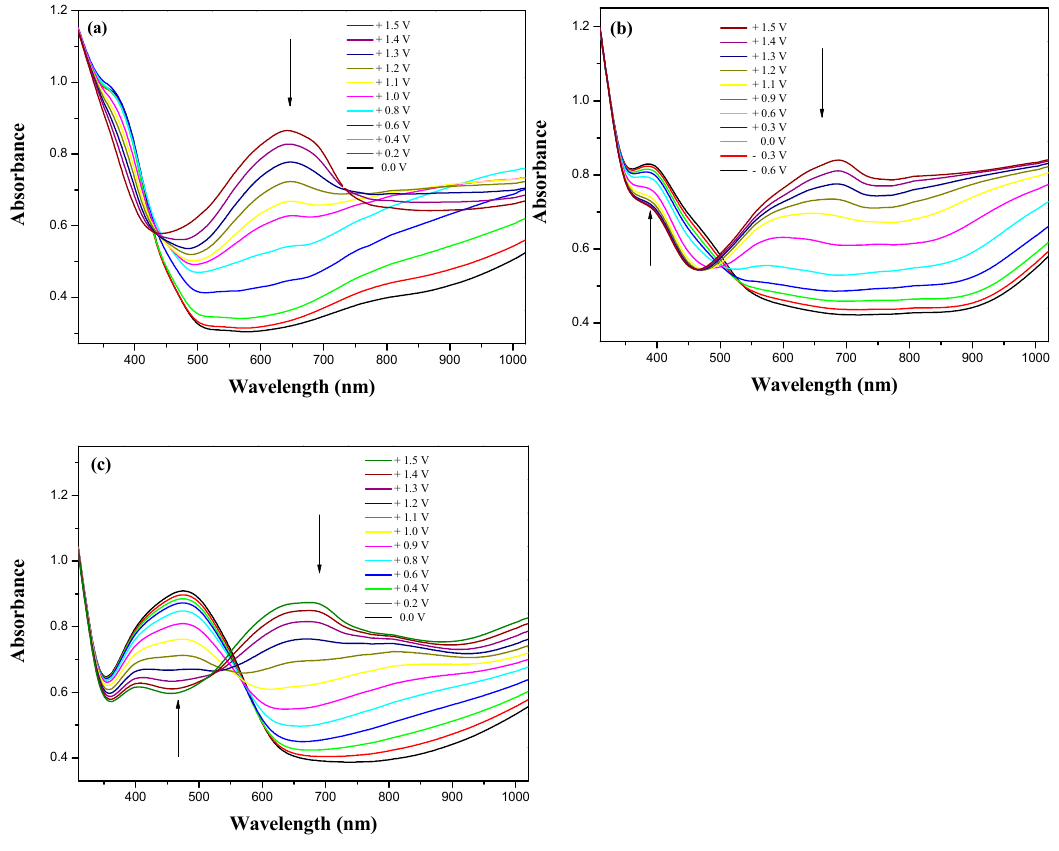
Figure 9. UV-Visible spectra of ( a ) PInc/PMMA-PC-ACN-LiClO 4 /PEDOT-PSS; ( b ) P(Inc- co -bT)/PMMA-PC-ACN-LiClO 4 /PEDOT-PSS; and ( c ) PbT/PMMA-PC-ACN-LiClO 4 /PEDOT-PSS ECDs.